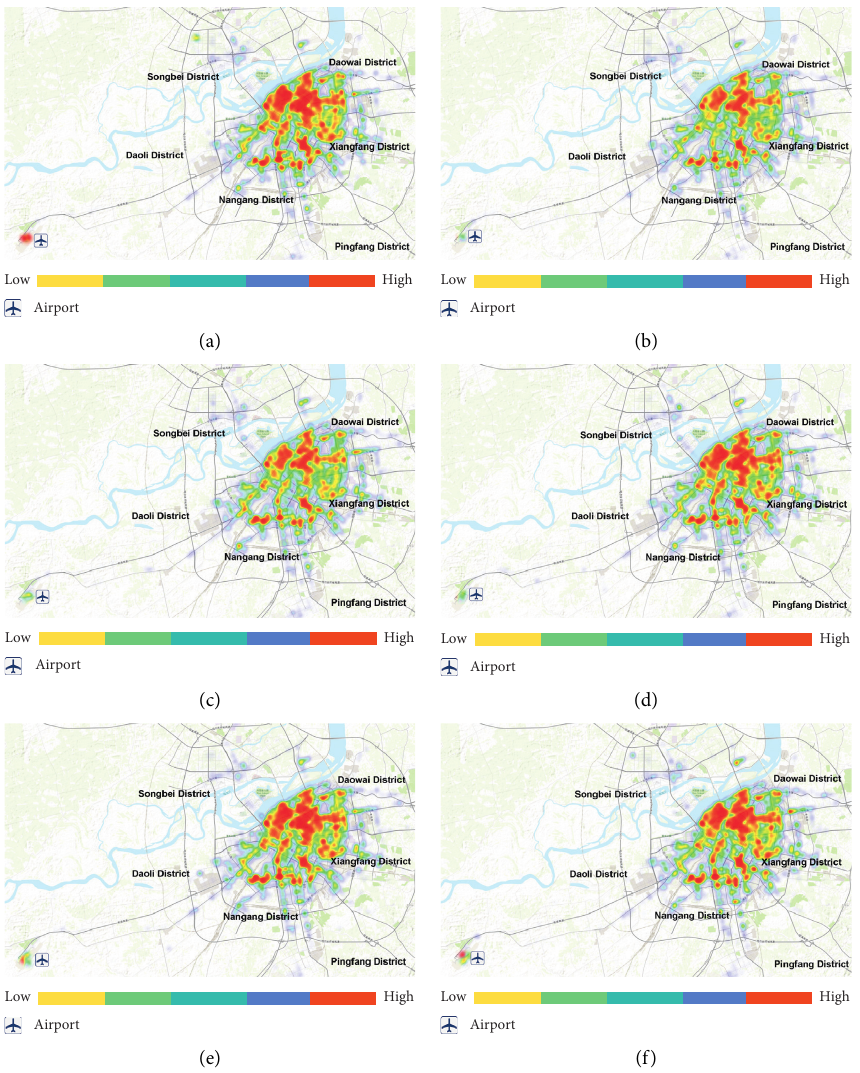
Figure 7: Spatial distribution of DOPs during the 6 days. (a) December 9, (b) December 10, (c) December 11, (d) December 12, (e) December 13, and (f) December